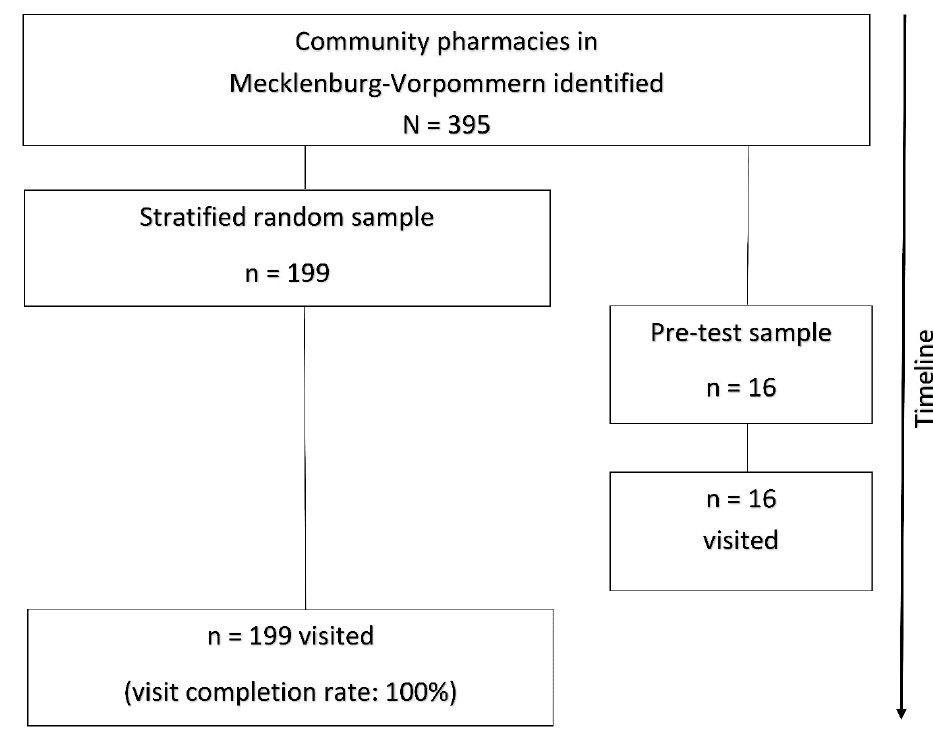
Figure 1. The design and flow of the study.